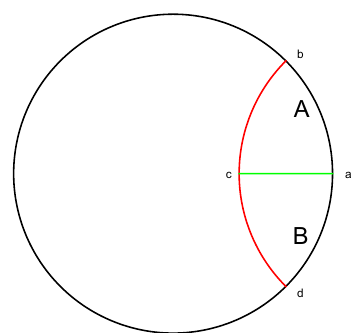
Figure 13. Graphical proof of the lower bound E